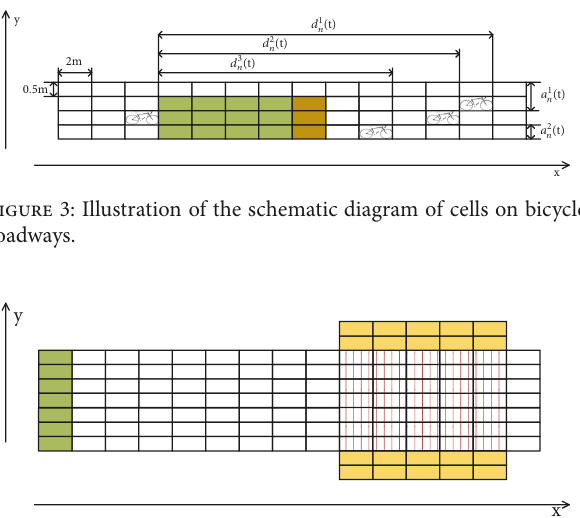
bicycle n and the nonoccupied cell in the left front, straight front, and right front